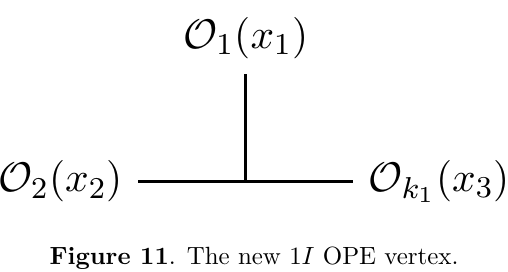
Figure 11 . The new 1 I OPE